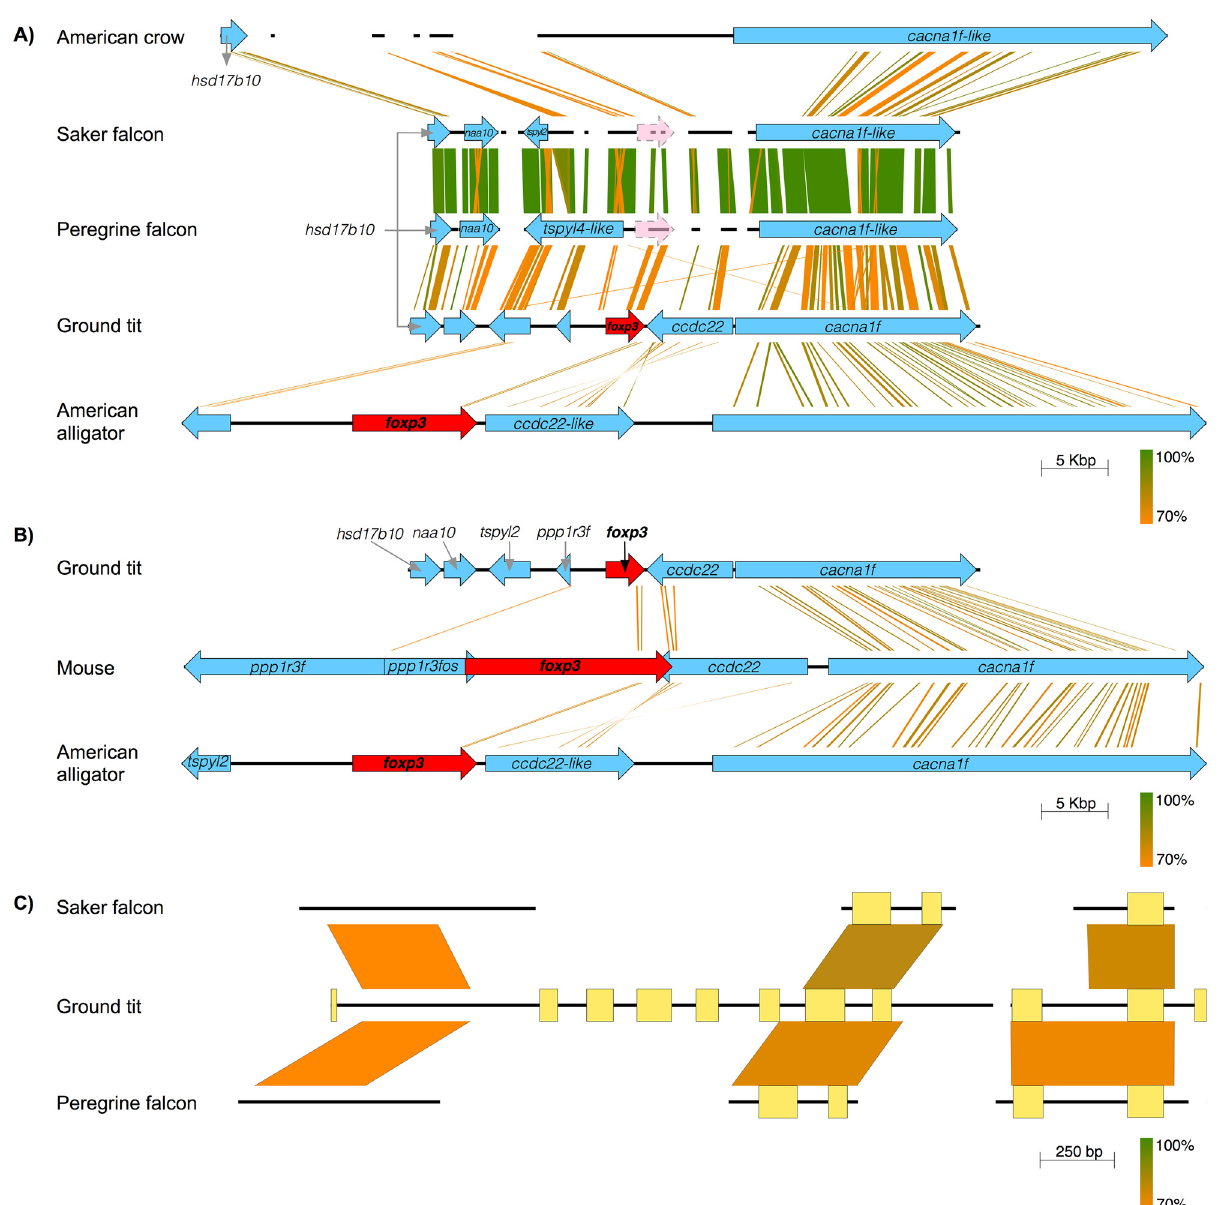
Fig 1. The genomic context of avian foxp3 . (A) The gene neighbourhood of foxp3 in a number of archosaurs showing the significant masked repeats of the American crow between hsd17b10 and cacna1f (gaps in the line indicate intergenic repeat regions), the approximate location of the foxp3 locus in the saker and peregrine falcon (marked by a pink arrow with a dashed line), and the low nucleotide sequence identity of foxp3 between the American alligator and the ground tit. In the displayed region the overall masked repeats are as follows: 54.7% in the American crow, 28.0% in the saker falcon, 31.4% in the peregrine falcon, 6.8% in the ground tit and 0.02% in the American alligator. (B) The foxp3 gene neighbourhood of the mouse, American alligator and ground tit, showing the gene variation upstream of foxp3 in mammals, birds and crocodilians and the low nucleotide sequence identity of murine foxp3 versus the American alligator and ground tit. (C) A comparison of the approximate foxp3 loci in both falcons with the ground tit foxp3 locus , showing masked repeats (gaps in the line) and predicted exons (rectangles). All subfigures were produced using Easyfig [47] with BLASTN identity comparisons indicated by the scales on each